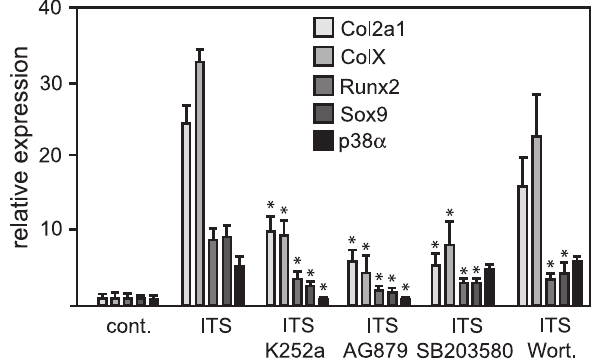
Figure 6. Effect of TrkB inhibition on Runx2 and Sox9 expression in ATDC5 cells. The murine chondrocytic osteosarcoma cells were cultured in differentiation media containing 10 m g/ml insulin and 25 m g/ml ascorbic acid; media was changed every other day for 6 days, at which time the indicated kinase inhibitors were added for an additional 3 days. Real-time RT-PCR was used to quantify mRNA levels of the marker proteins. Data points were calculated using the DD Ct method and represent the mean 6 SD of real-time data from five sample pairs, expressed as fold difference from insulin alone (the calibrator). *, P ,